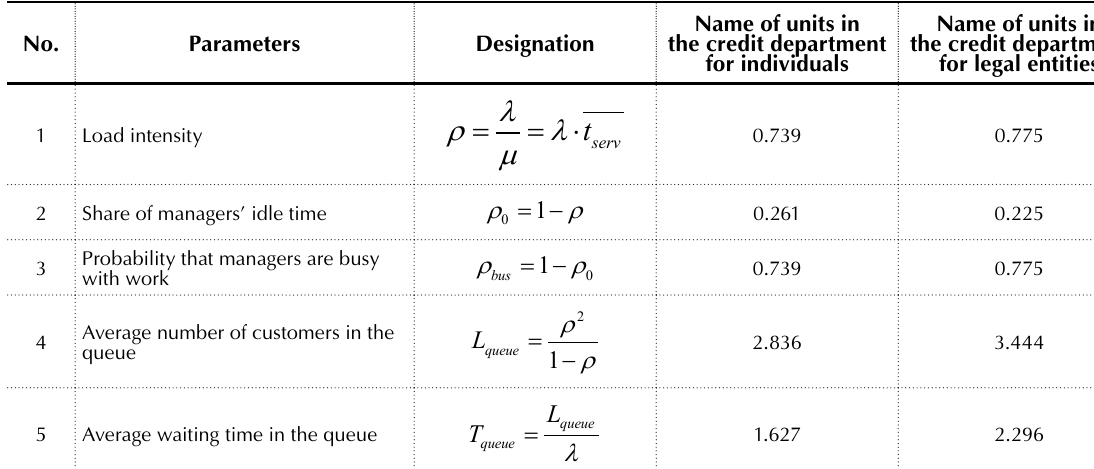
Table 9. Performance characteristics of the bank’s credit departments, represented by the multichannel waiting